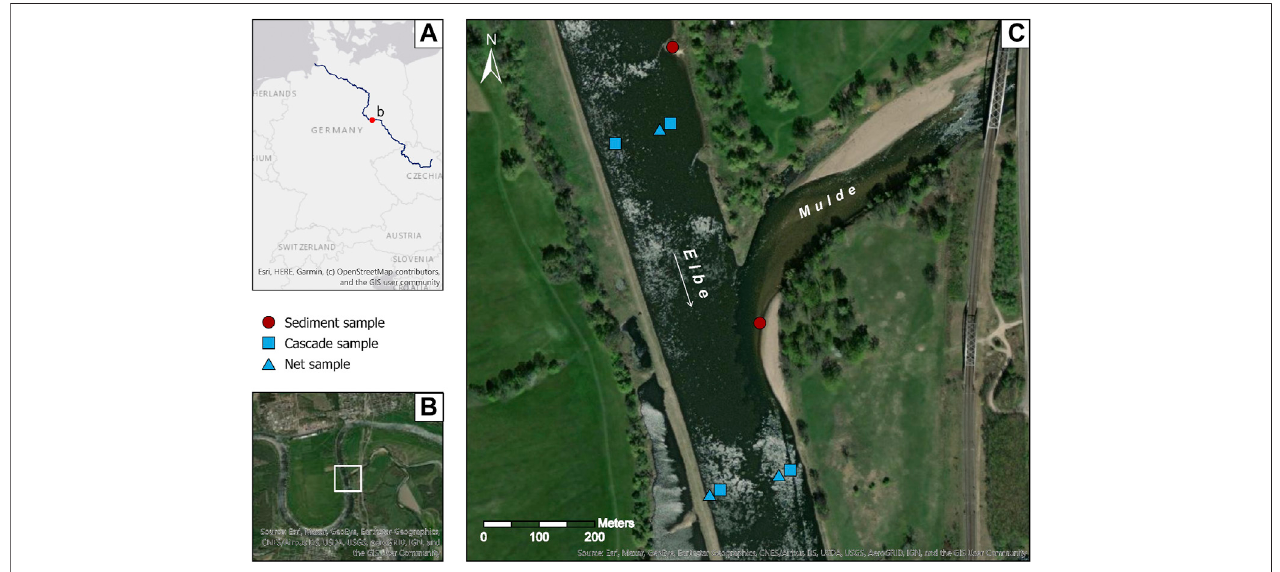
FIGURE1|(A,B) LocationoftheElbe – Muldecon fl uenceinDessau-Roßlau(Germany). (C) Onesedimentsampleandthreewatersamplesweretakenupstreamof the con fl uence, and four water samples and one sediment sample were taken downstream.